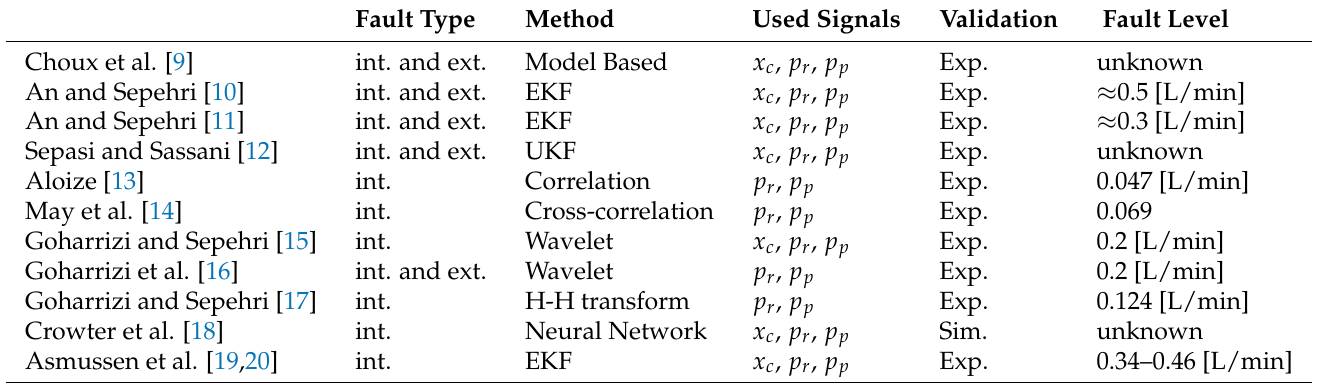
Table 1. Covered fault detection methods for actuator leakage failures. The notations of the used signals can be found in Figure